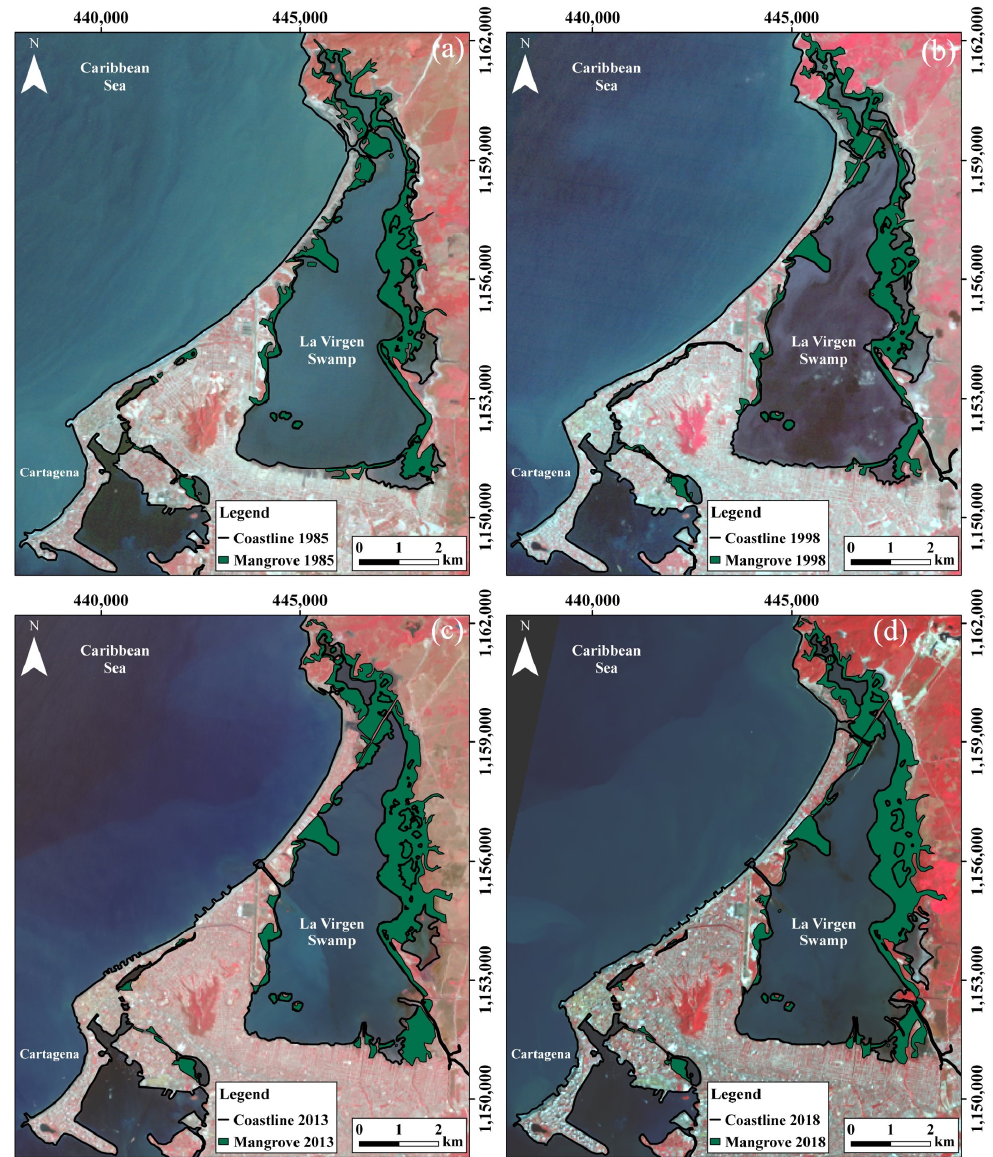
Figure 5. Evolution of the mangrove forest (green) in La Virgen swamp: ( a ) 1985, ( b ) 1998, ( c ) 2013, and ( d ): 2018.